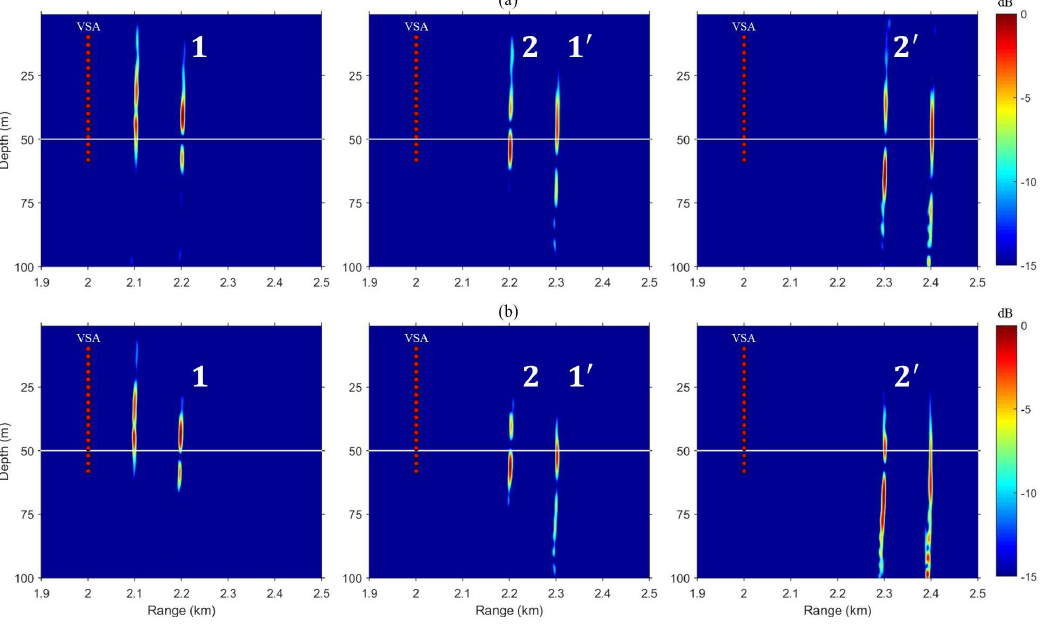
Figure 7. (Color online) Simulated adaptive VSA-based multiple TR focusing using MCM method. Each panel represents a backpropagated field corresponding to a different single snapshot time. ( a ) For isovelocity SSP; ( b ) For downward-refracting SSP. The numbers here correspond one-to-one with the time series in Figure